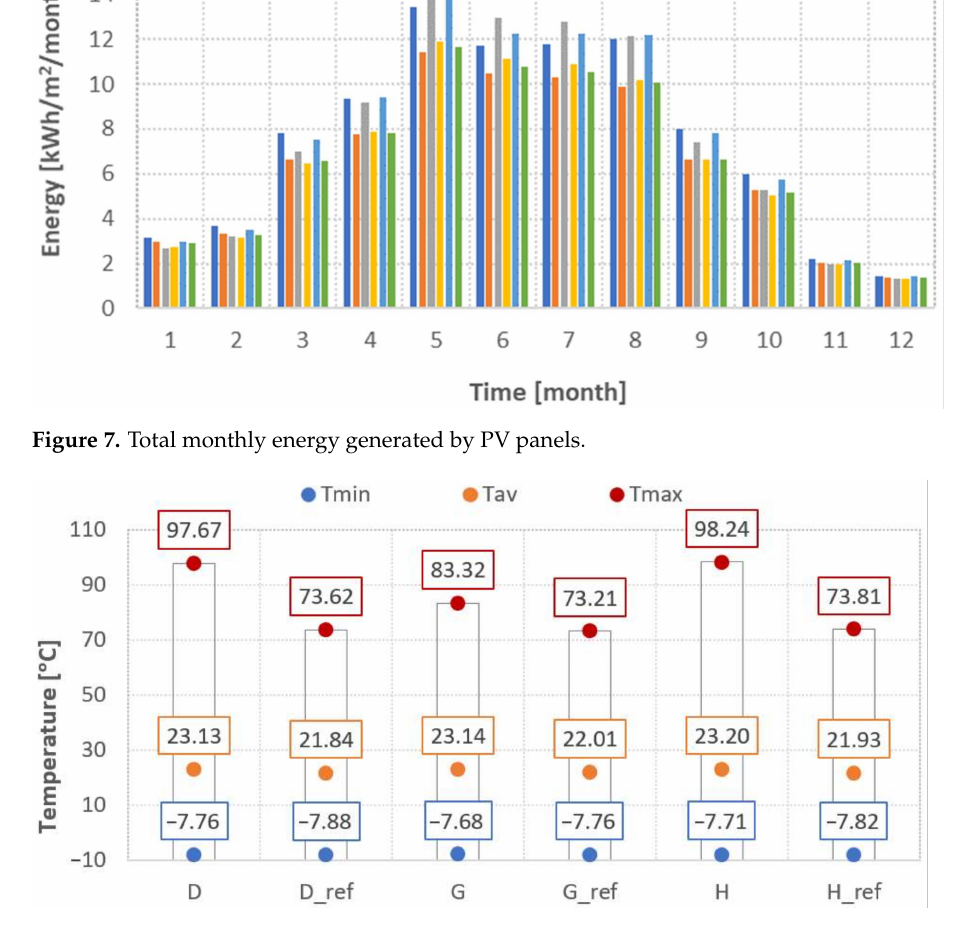
Figure 8. Temperature range of PV panels including minimum, maximum and average temperature during operation of PV panels.